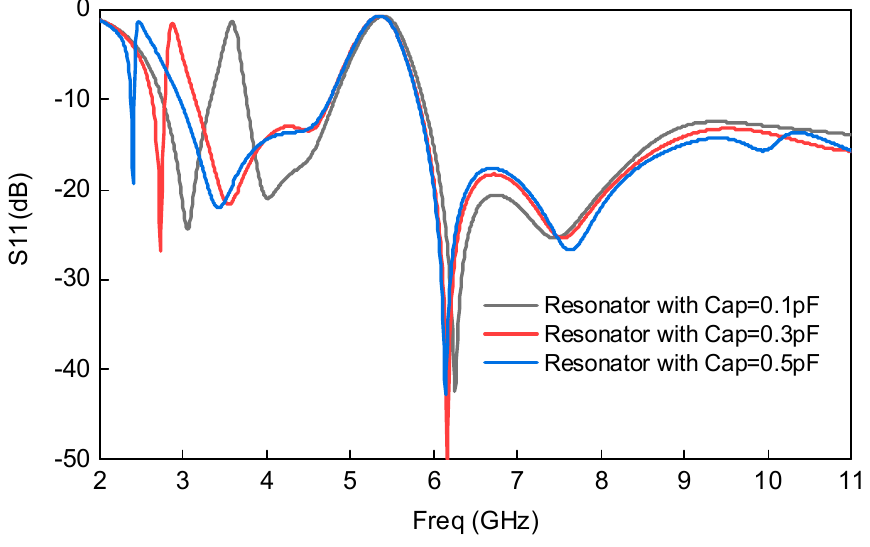
Figure 5. The reflection coefficient of the UWB antenna that included an integrated resonator with Cap variation from 0.1 pF to 0.5 pF.